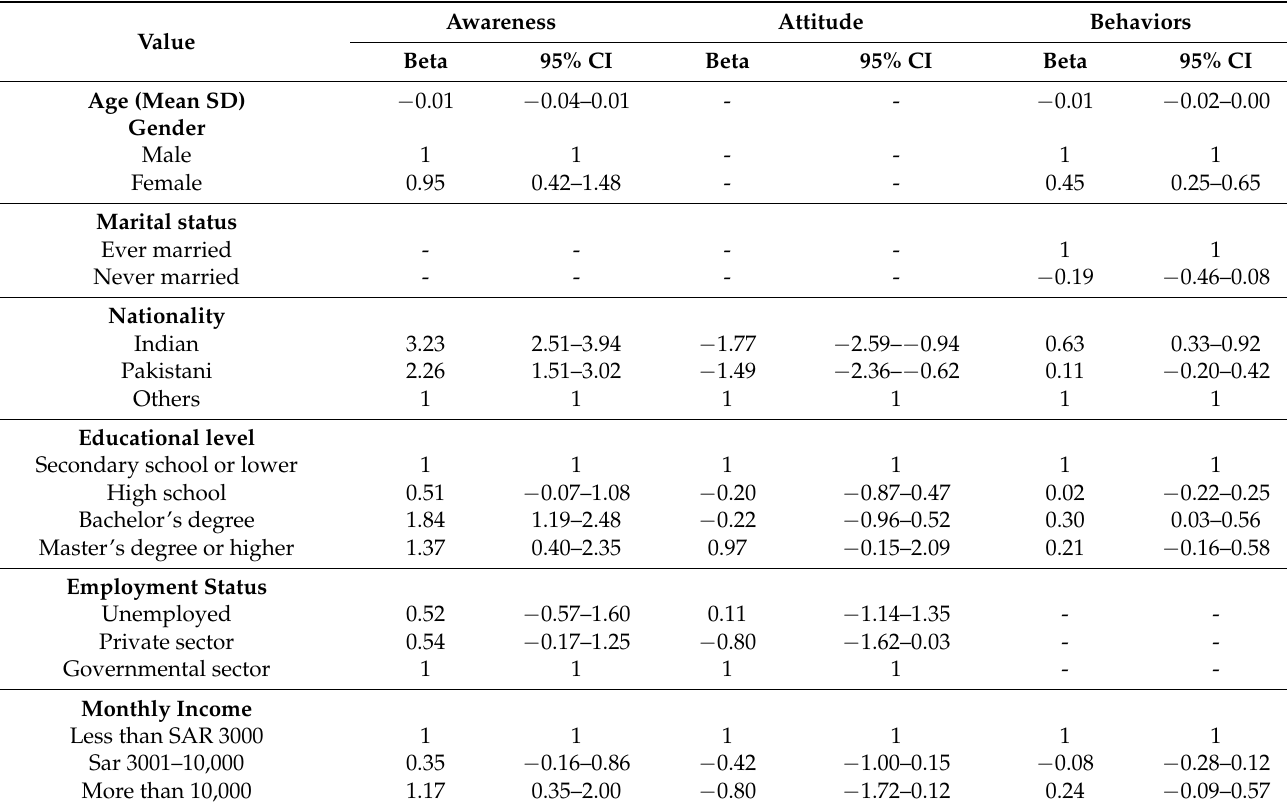
Table 2. Predictors of COVID-19-related awareness, attitude, and behaviors of travelers arriving in KSA.